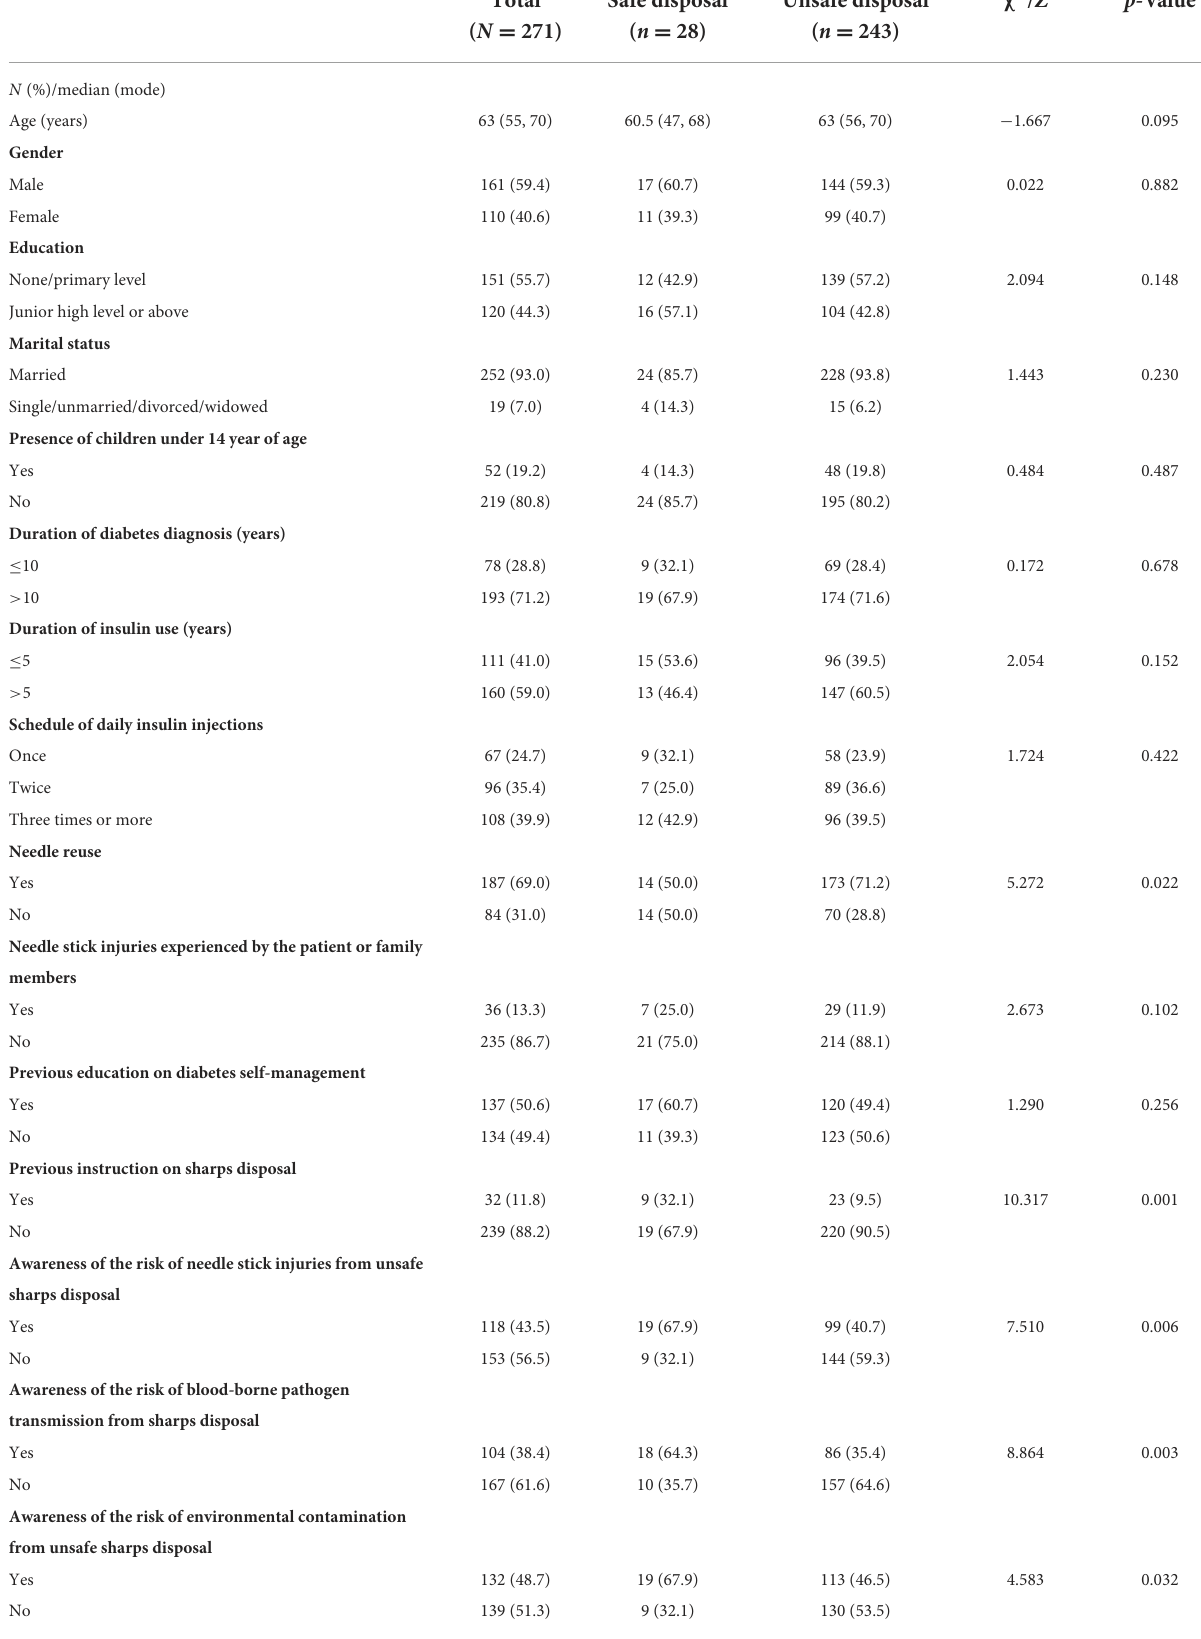
TABLE 1 Univariate analysis of factors associated with safe disposal of insulin needles.